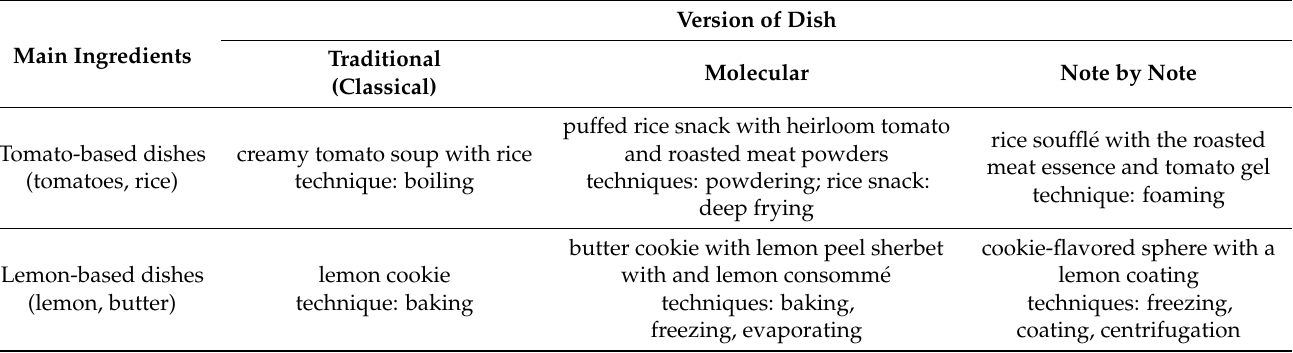
Table 1. The versions of dishes used in the